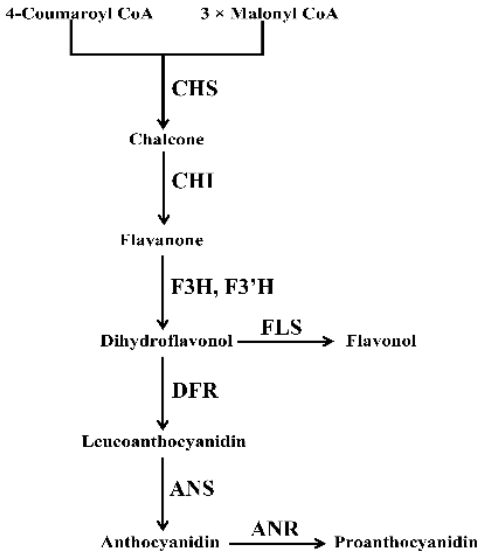
Figure 1. A general schematic diagram of the metabolic pathway related to anthocyanin biosynthesis. CHS, chalcone synthase; CHI, chalcone isomerase; F3H, flavanone 3-hydroxylase; F3 ′ H, flavonoid 3 ′ -hydroxylase; DFR, dihydroflavonol 4-reductase; ANS, anthocyanidin synthase; FLS, flavonol synthase; ANR, anthocyanidin reductase.